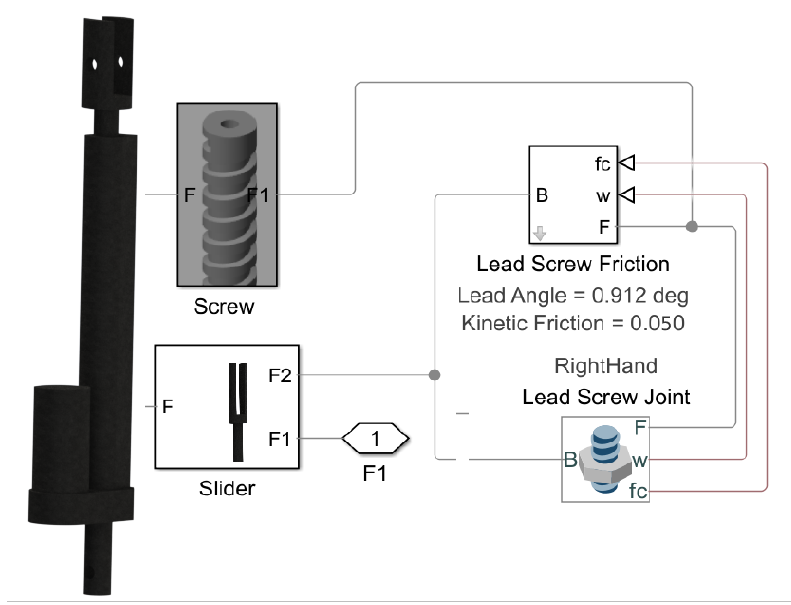
Figure 5. Multibody model of the lead screw